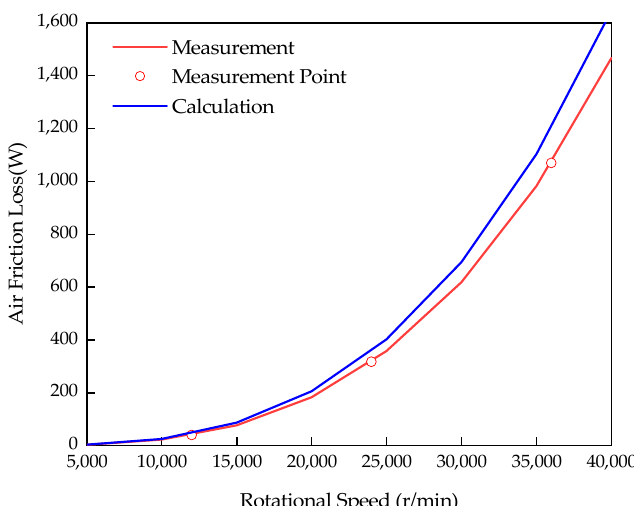
Figure 29. Comparison of measurement and calculation results of air friction loss at different rota- tional speeds.